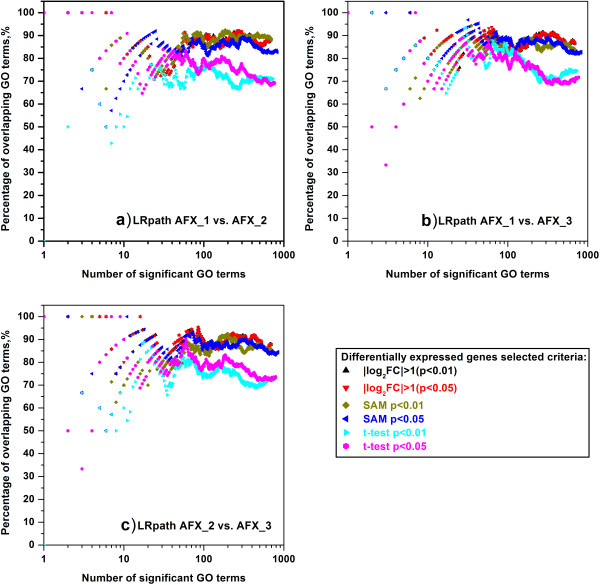
Intra-platform concordance of significant GO terms enriched by LRpath among three test sites of AFX. (a) AFX_1 versus AFX_2; (b) AFX_1 versus AFX_3; (c) AFX_2 versus AFX_3. The scatter plots showed the percentage of overlapping GO terms which were enriched by LRpath and derived from two test sites. See notes under Figure 2 for more information.